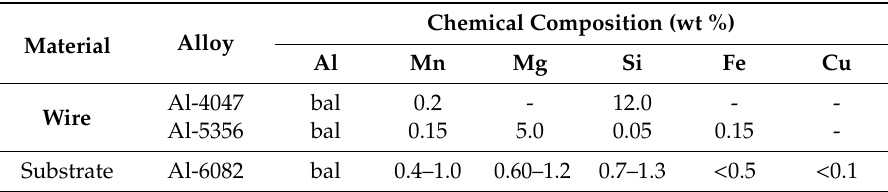
Table 1. Nominal composition of welding